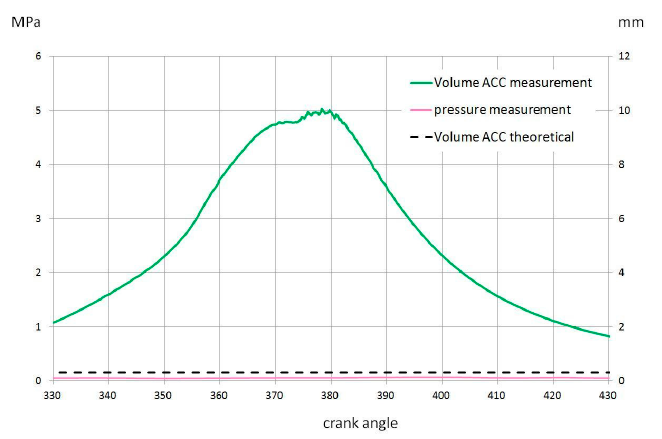
Figure 14. Curve of indicated pressure without volume change in the ACC system, (cr = 17.1: 1, 13 bar) without relative volume in the theoretical complementary system (cr = 17:1).